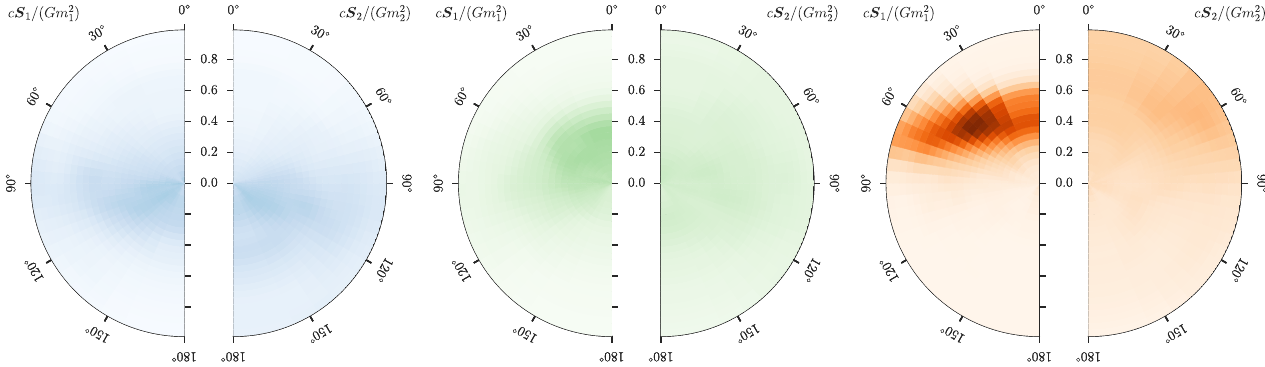
FIG. 5. Posterior probability distributions for the dimensionless component spins cS 1 = ð Gm 2 1 Þ and cS 2 = ð Gm 2 2 Þ relative to the normal to the orbital plane L , marginalized over the azimuthal angles. The bins are constructed linearly in spin magnitude and the cosine of the tilt angles, and therefore have equal prior probability. The left plot shows the distribution for GW150914, the middle plot is for LVT151012, and the right plot is for GW151226.